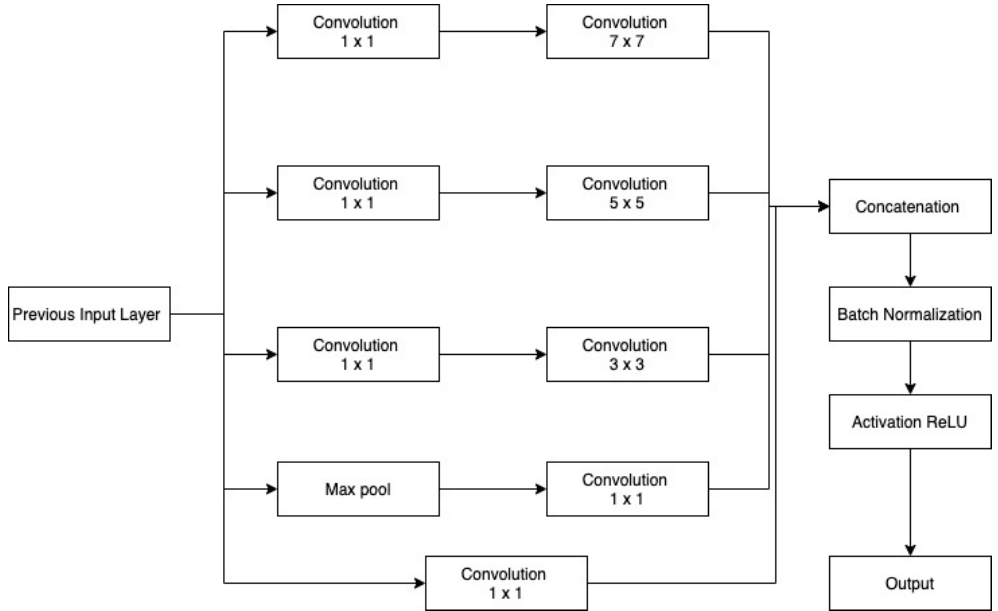
Figure 4. MI: Inception block